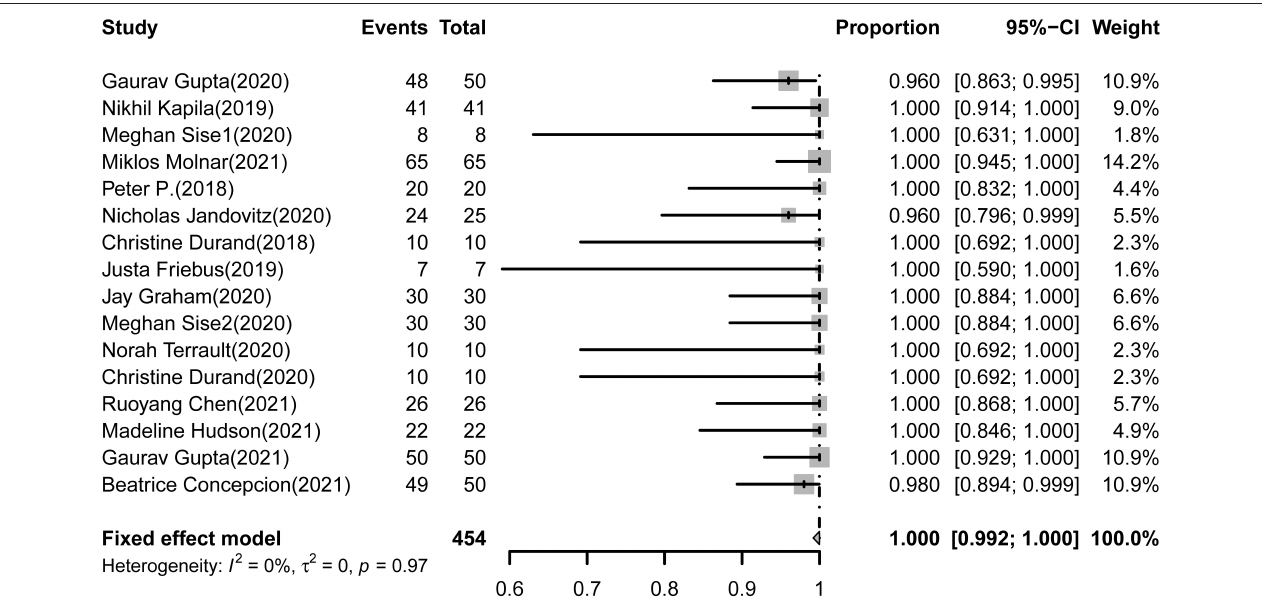
FIGURE 2 | Forest plot of pooled SVR rates of DAAs treatment for HCV-negative recipients received HCV +